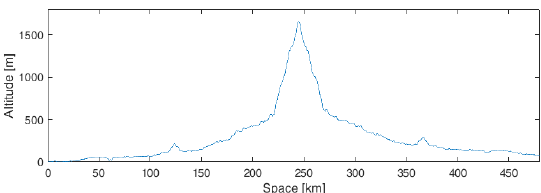
Figure 21. Altitude profile, highway-mountain.